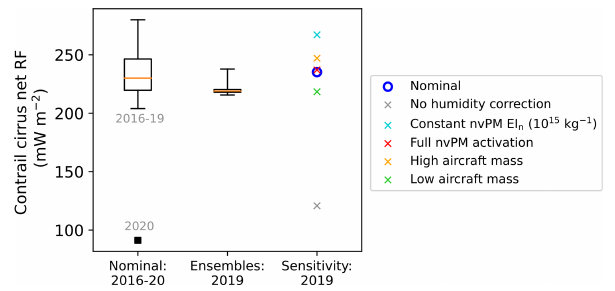
Figure 7. Comparison of the annual contrail cirrus net RF in the North Atlantic provided by (i) the nominal simulations using the ERA5 HRES (2016–2020), (ii) the ERA5 10-member ensemble and (iii) the sensitivity analyses for